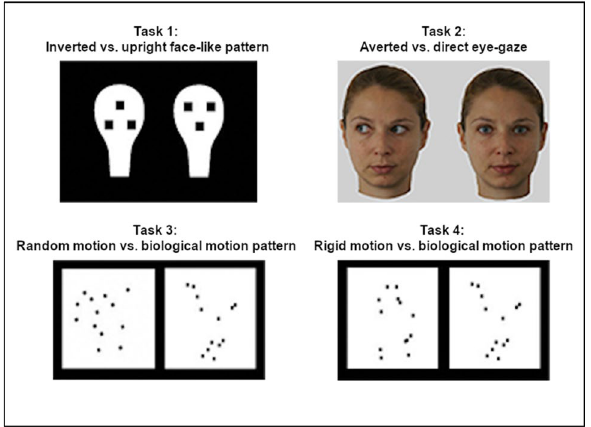
Figure 1. Stimuli used for testing visual preferences. Such stimuli are the same employed in our previous study (Di Giorgio et al. 32 , Scientific Reports) and, as regard with face image, informed consent to publish was obtained from the represented